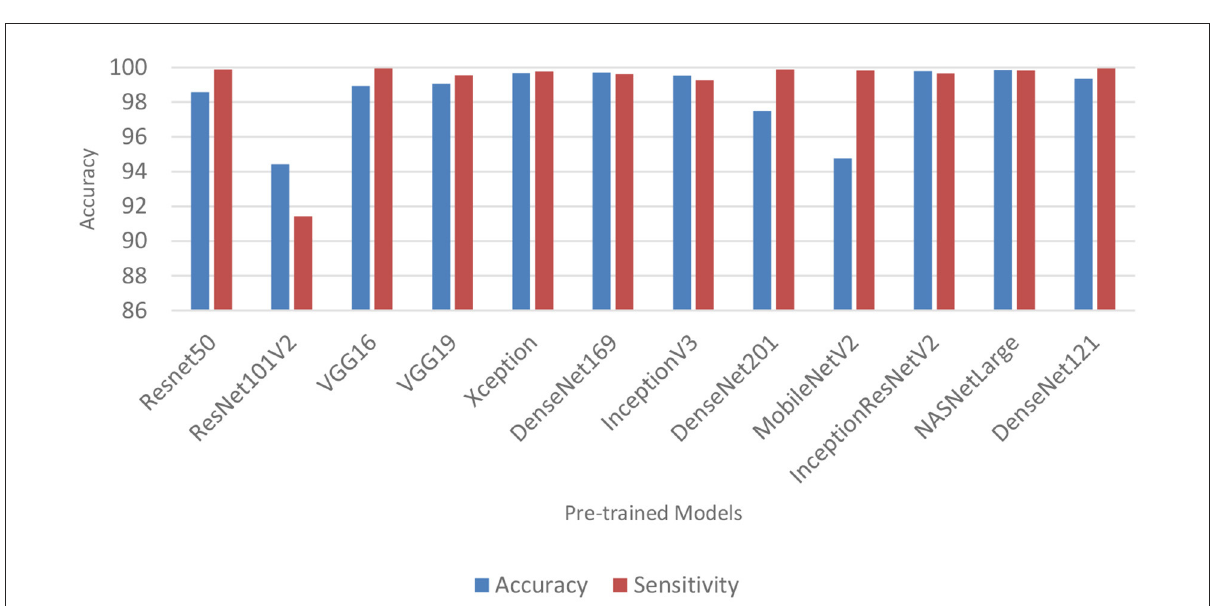
FIGURE4 Classification accuracy and sensitivity of models with data